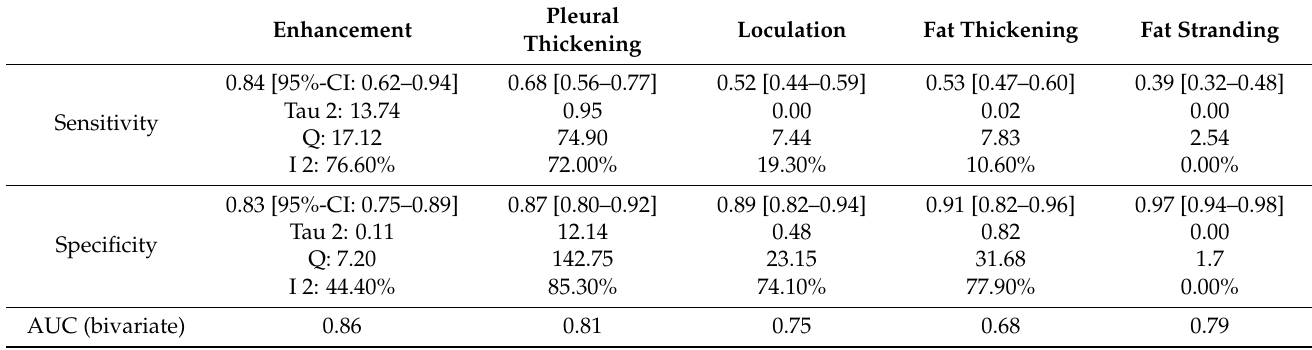
Table 3. Syntheses of the pleural findings with the pooled sensitivities and